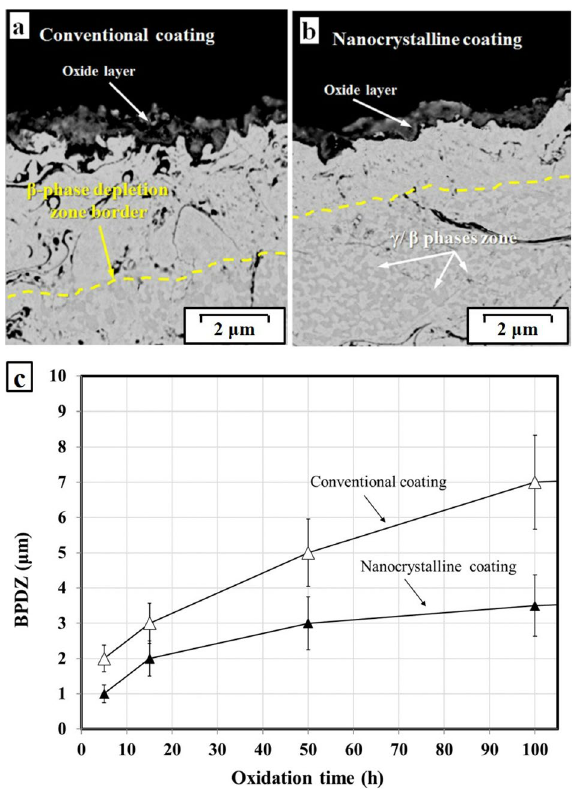
Figure 17. The BPDZ for the ( a ) conventional and ( b ) nanocrystalline MCrAlY coatings after isothermal oxidation at 1000 °C up to 100 h and ( c ) variations of BPDZ versus oxidation exposure time at 1000 °C up to 100 h.